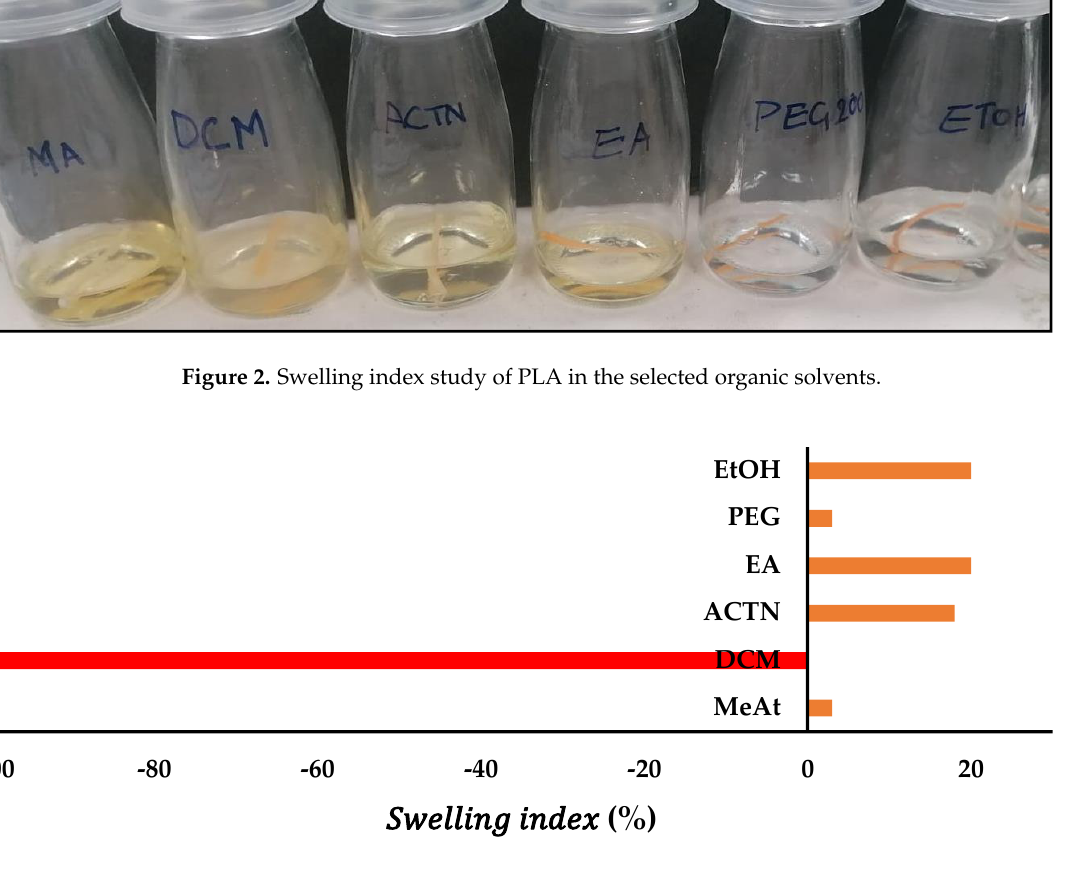
Figure 2. Swelling index study of PLA in the selected organic solvents.